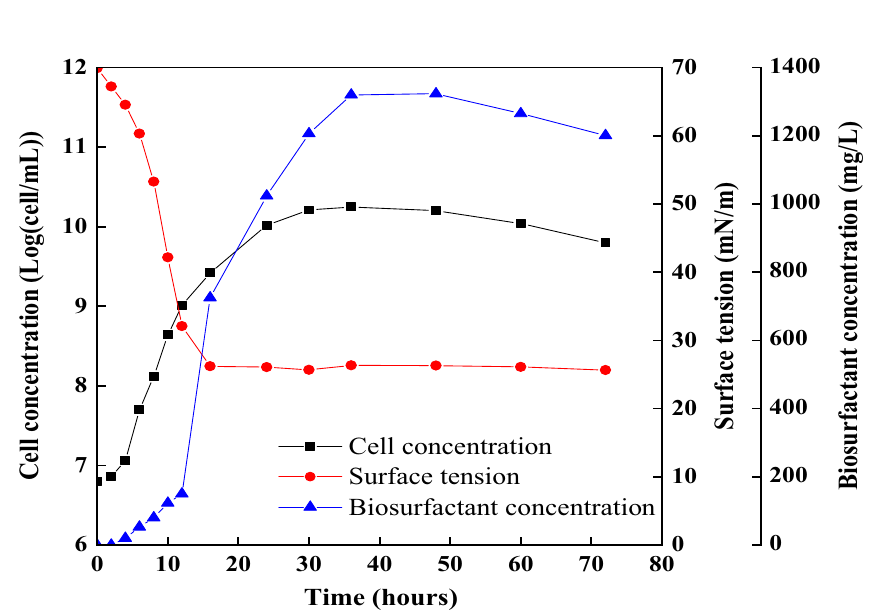
Figure 4. The change of cell concentrations, surface tension, biosurfactant